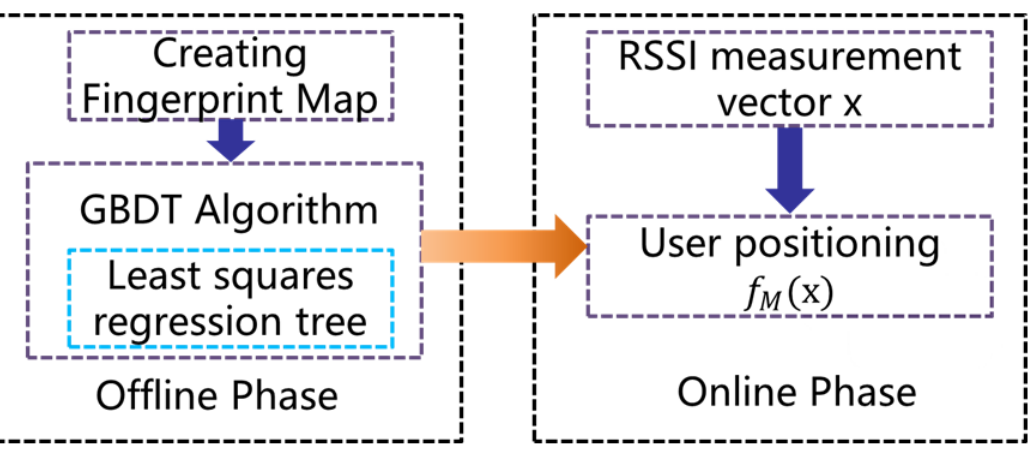
Figure 10. Wi-Fi fingerprint positioning algorithm based on GBDT.